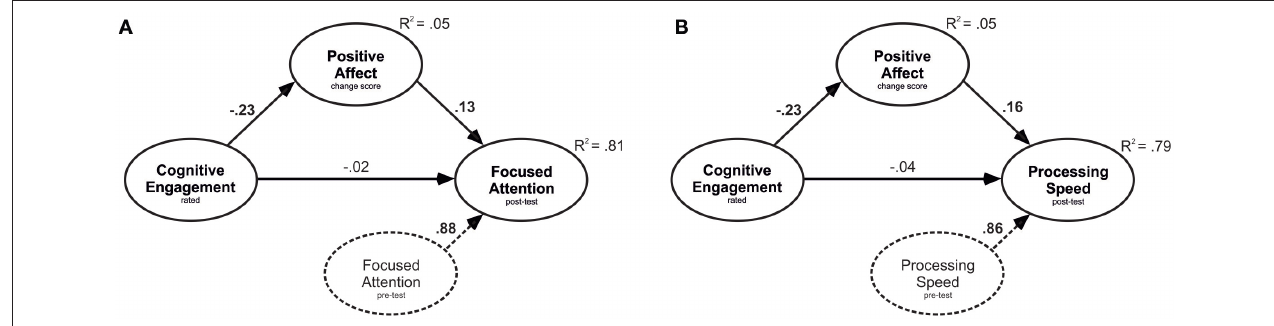
FIGURE 1 | Path diagram of the two models, with rated cognitive engagement as the predictor variable, positive affect change score as the mediator, and (A) focused attention and (B) processing speed, respectively, as the outcome variable. All reported path coefficients (bold when significant, p < 0.05) are standardized estimates. Covariates are shown as dashed